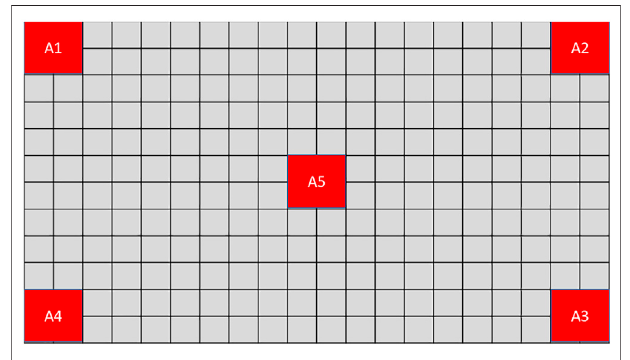
FIGURE 3 | A representation of the MindTrails environment, with fi ve anchors A1 to